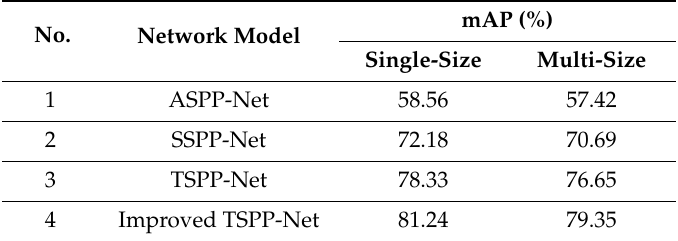
Table 1. Mean average